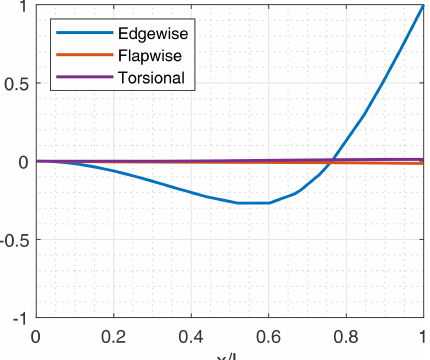
Figure 3. An illustration of a typical damping ratio versus rotor speed plot. The transition for edgewise instability and classical flut- ter is shown. Please note the scale for the edgewise instability damp- ing is 1 / 10th that of classical flutter damping.